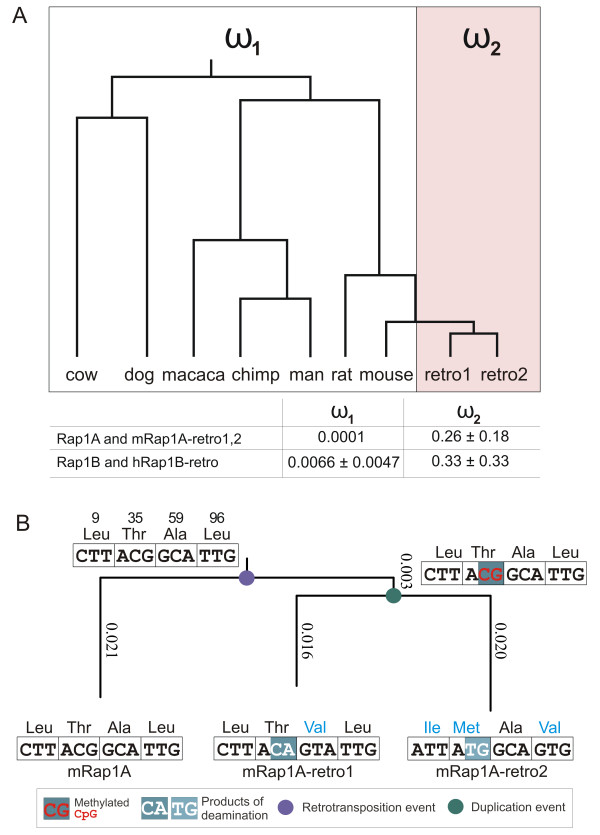
Codon evolution model of Rap1 retrogenes. A. The phylogenetic tree depicts the evolution of mammalian Rap1A orthologs and the two mouse Rap1A retrogenes. To check whether the two retrogenes are functional, we compute ω-ratios of non-synonymous to synonymous substitutions with the clades model of PAML. We assume one ω1-ratio for the left part of the tree whereas the evolution of recently emerged retrogenes is modelled by an individual ω2-value. Table shows the estimated ω-values and their standard deviations as computed by PAML. The amino acid sequences of mammalian Rap1A orthologs are fully conserved and the ML estimate ω1 = 0.0001 is too close to zero for PAML to compute a standard deviation. B. The evolution of the two mouse Rap1A retrogenes involved a retrotransposition event and a subsequent duplication event. Vertical edge lengths in the tree dendrogram were computed by the PAML software and scale with the expected number of neutral synonymous substitutions under the 2-clades codon evolution model. Leaves and internal nodes are annotated with the four codons at positions 9, 35, 59, 96, where non-synonymous subsitutions occured. Codons at internal nodes were reconstructed by applying the Maximum Parsimony principle to single nucleotide substitutions. It can be hypothesized, that non-synonymous (T35 M) and synonymous (T35T) mutations at codon 35 observed in mRap1A-retro1 and mRap1A-retro2, respectively, result from deaminations of methylated CpG dinucleotide. Non-synonymous mutations are highlighted in cyan.